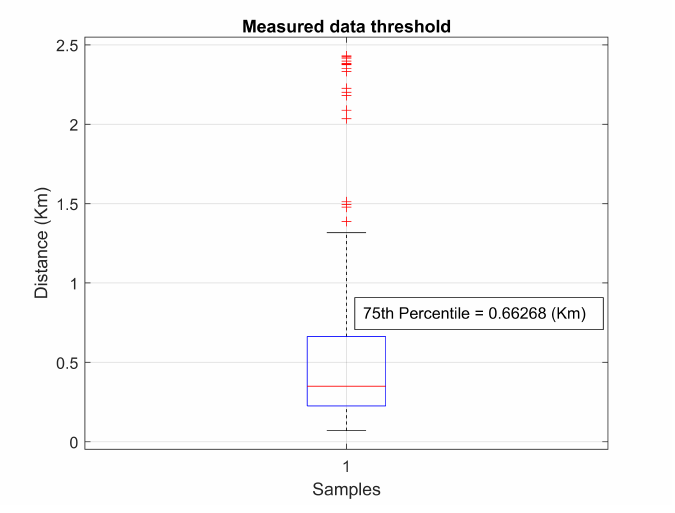
Figure 7. Statistical analysis of coverage